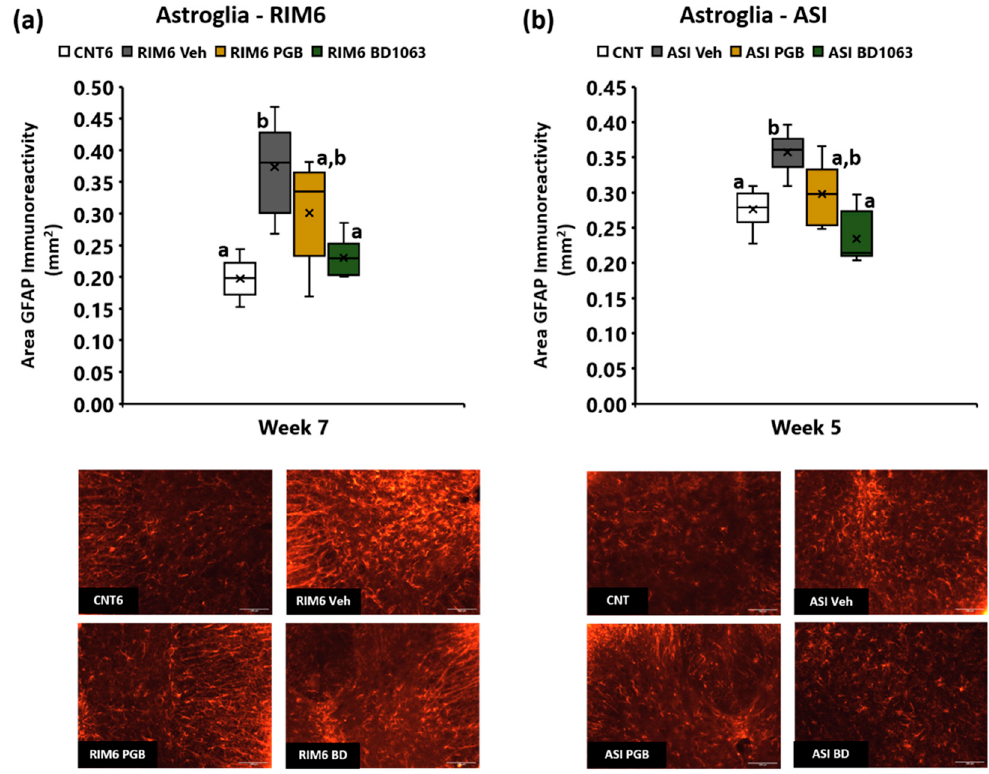
Figure 5. Spinal cord astrogliosis in mice subjected to ( a ) reserpine-induced myalgia and ( b ) intramuscular acid saline solution injection, and treated with saline solution, BD1063, or pregabalin. Representative histological images of the spinal cord immunostained for GFAP of each group (scale bar 100 μ m) are shown in the bottom of the figure. Data are expressed as the median ± IQR, and the mean is also shown as x. a,b: Groups not sharing a letter showed significant differences respect to control group, p < 0.05.